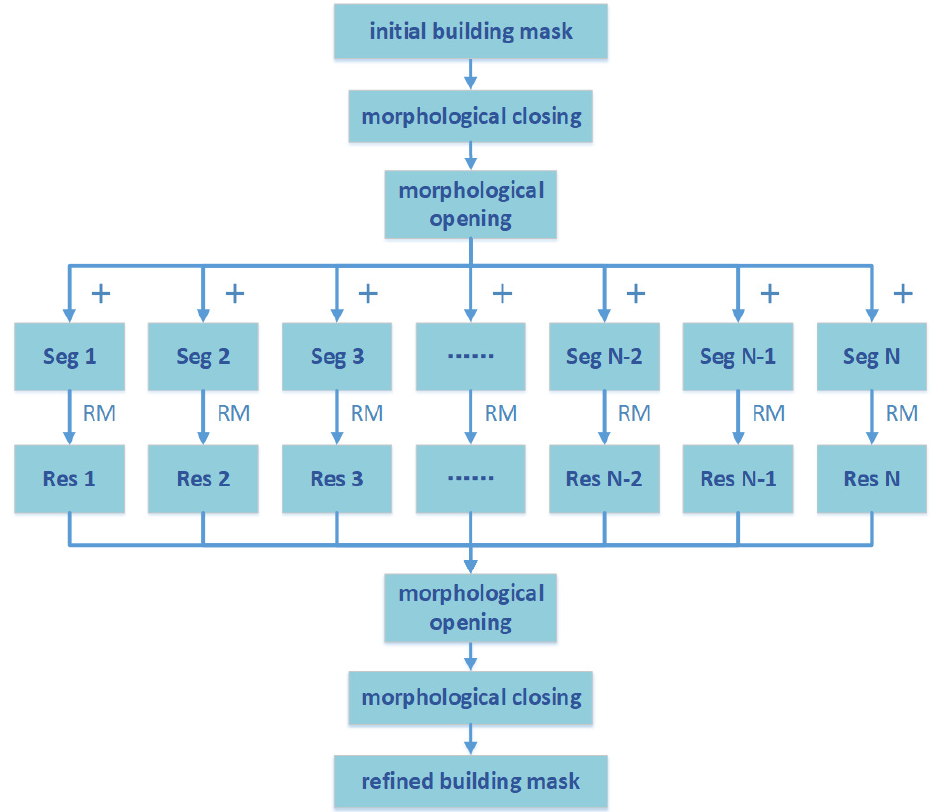
Figure 2. Workflow of our building-mask refinement method based on the image feature consistency constraint. Seg denotes the image segmentation obtained by a non-semantic image segmentation algorithm, such as the GS [80], SLIC [81] and ERS [82] algorithms used by us; Res denotes a region matching result; and RM stands for region